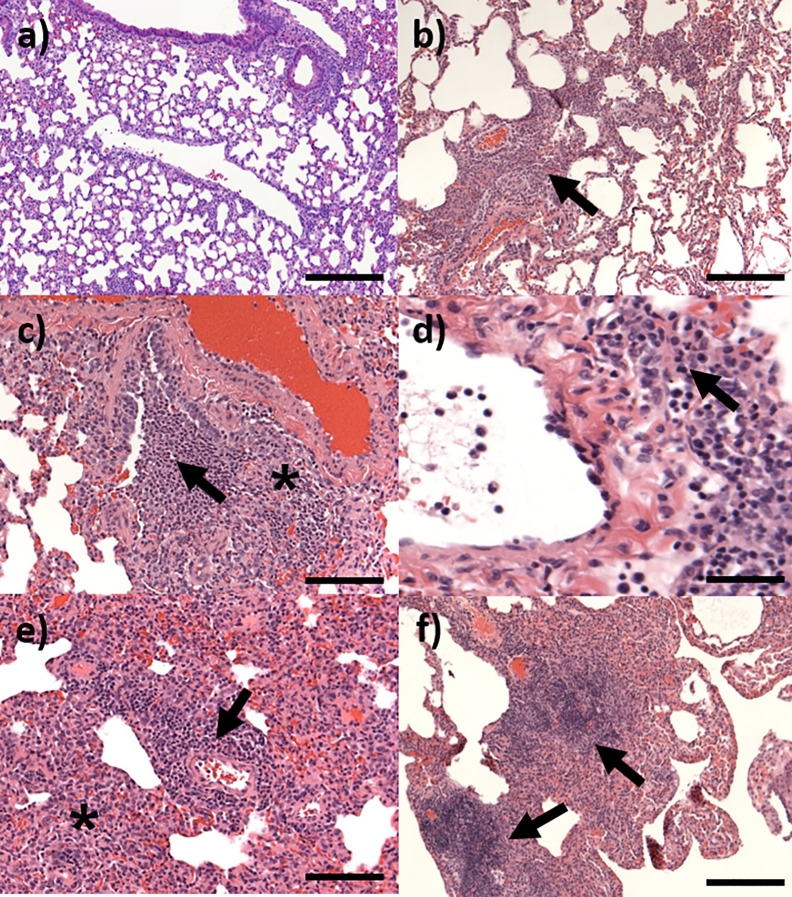
Representative H&E stained lung sections from marmosets challenged with C. burnetii. (A) Day 3 post-challenge showing no changes, bar =200 μm; (B) Day 7 post-challenge showing pyogranulomatous alveolitis (arrow), bar =200 μm; (C) Day 7 post-challenge showing focal bronchiolitis with infiltrating cells in the walls (*) and lumen (arrow), bar =100 μm; (D) Day 14 post-challenge showing perivascular cuffing (arrow) of an artery, bar=50 μm; (E) Day 21 post-challenge showing pyogranulomatous alveolitis (*) and lymphocytic, perivascular cuffing (arrow), bar=100 μm; (F) Day 28 showing moderate granulomatous infiltration (arrows), bar =200 μm.